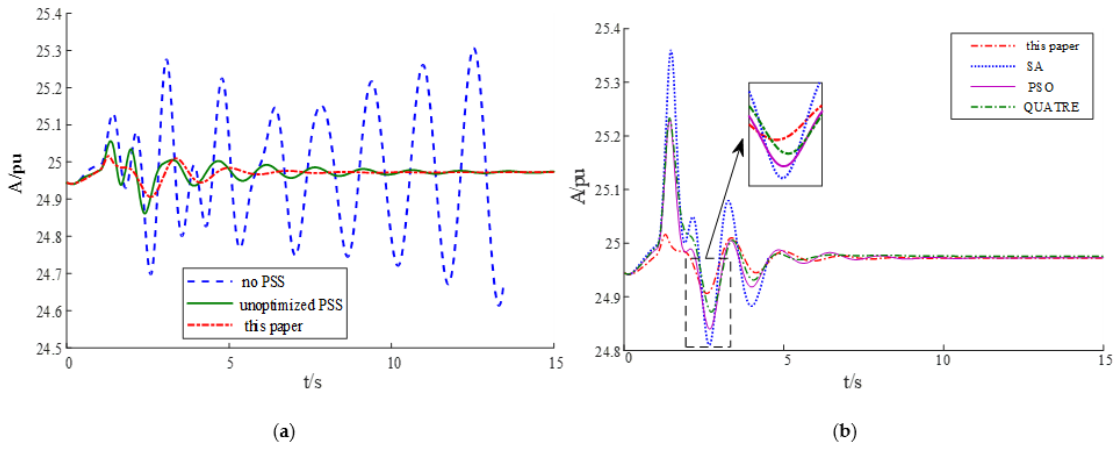
Figure 8. Power angle signal: ( a ) Comparison between the method in this paper and the unoptimized PSS; ( b ) Comparison of multiple algorithms to optimize PSS.